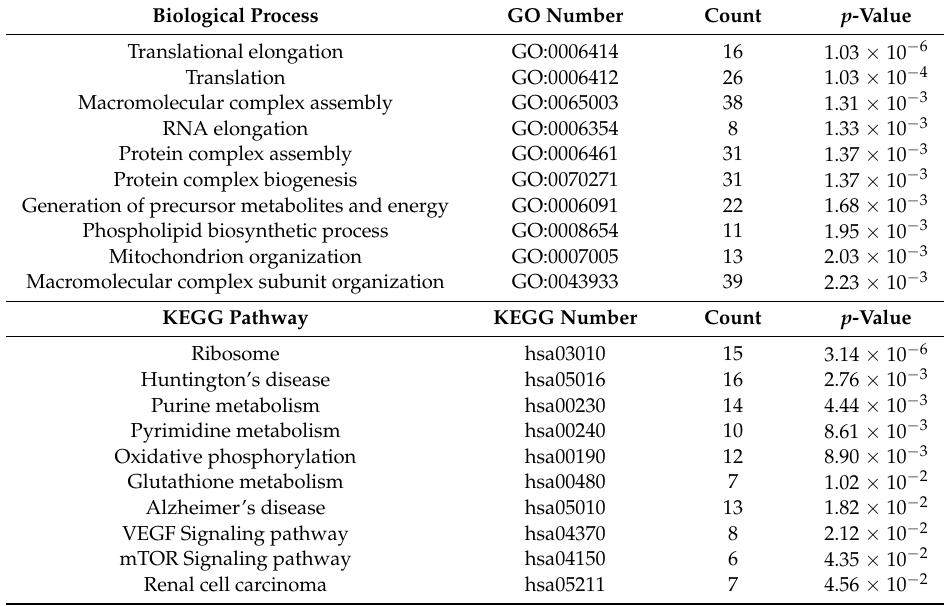
Table 2. Gene ontology terms enriched among miR-210 target genes. Most significantly enriched biological processes and Kyoto Encyclopedia of Genes and Genomes (KEGG) pathways from miR-210 pull-down targets. Generated using the Database for Annotation, Visualization, and Integrated Discovery (DAVID) functional annotation tool. Count indicates number of miR-210 target genes associated with each annotation; significance cutoff = p -value <